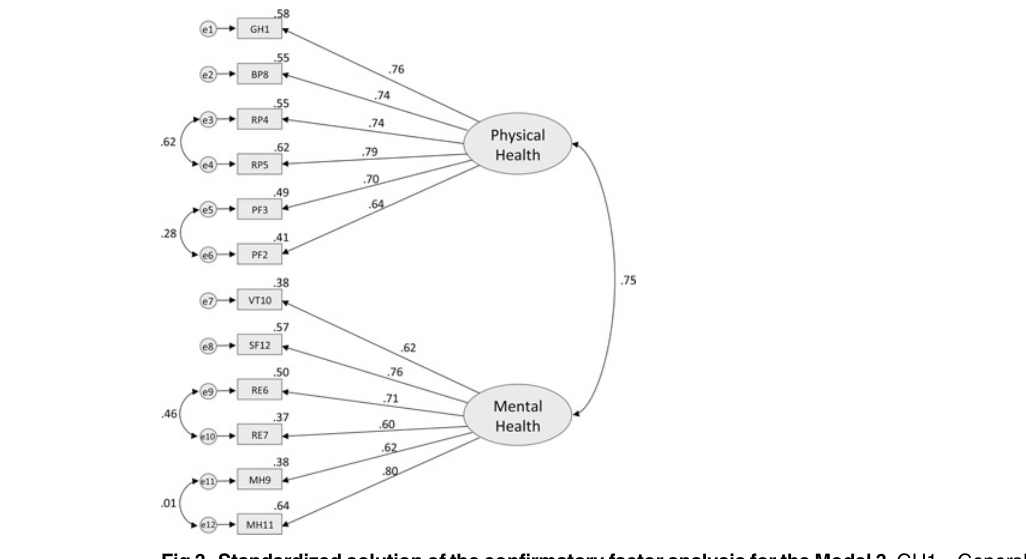
Fig 3. Standardized solution of the confirmatory factor analysis for the Model 3. GH1 — General Health: rating of general health; PF2 — Physical Functioning: moderate activities; PF3 — Physical Functioning: climbing several flights of stairs; RP4 — Role Functioning (Physical): accomplished less; RP5 — Role Functioning (Physical): limited in the kind work or other activities; RE6 — Role Functioning (Emotional): accomplished less (emotional problems); RE7 — Role Functioning (Emotional): less carefully than usual; BP8 — Bodily Pain: pain interference; MH9 — Mental Health: calm and peaceful; VT10 — Vitality: energy; MH11 — Mental Health: downhearted and depressed; SF12 — Social Functioning: health/emotional problems interfered with activities.